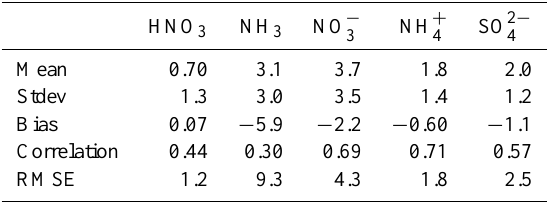
Table 3. Statistical comparison between modelled and measured concentrations. Modelled average and standard deviation are given for each component as well as the correlation ( R ), bias and root mean squared error (RMSE) in comparison to the measurements.